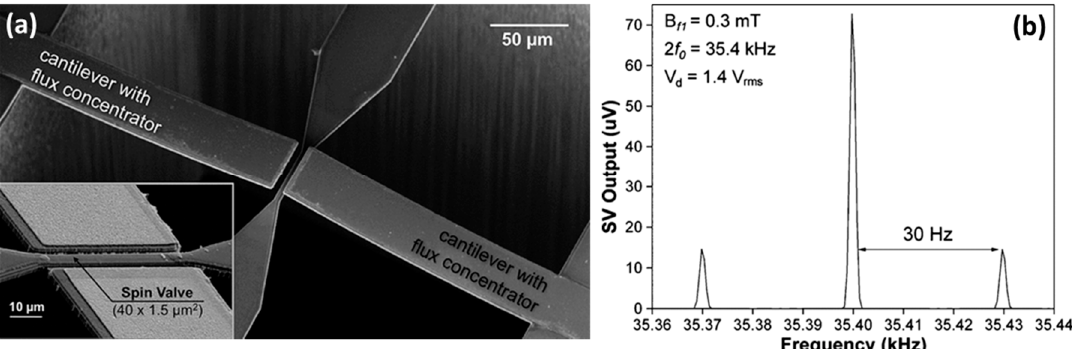
Figure 9. ( a ) SEM image of the developed device, showing the SV sensing element between two resonator cantilevers with integrated MFCs; ( b ) Acquired data resulting from the modulation of a low-frequency AC field (0.3 mT with a frequency of 30 Hz), exhibiting the respective sidebands when the cantilevers are actuated at the resonance frequency ( f 0 = 17.7 kHz). Reproduced with permission